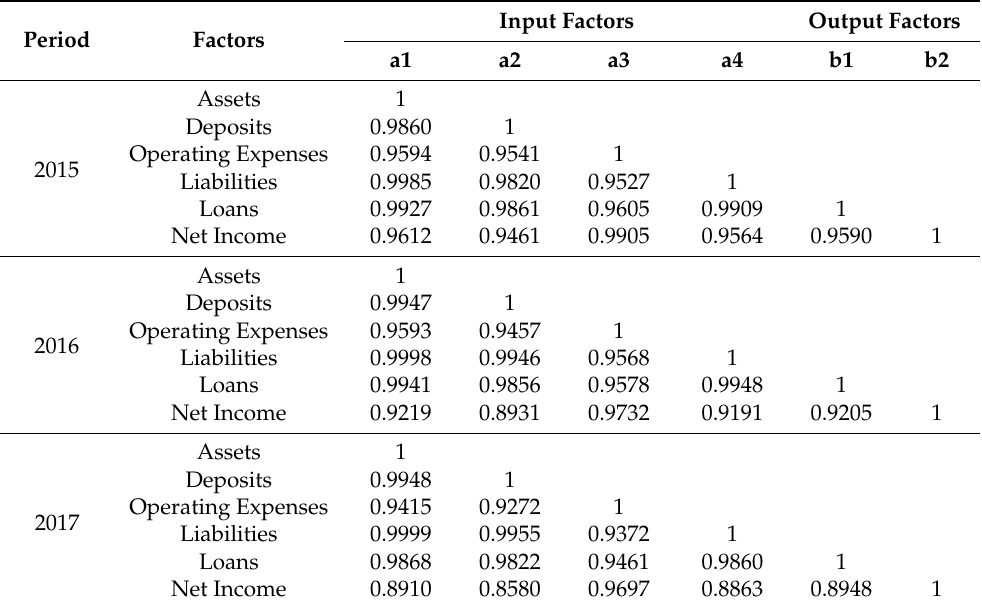
Table 4. Coefficients of correlation between